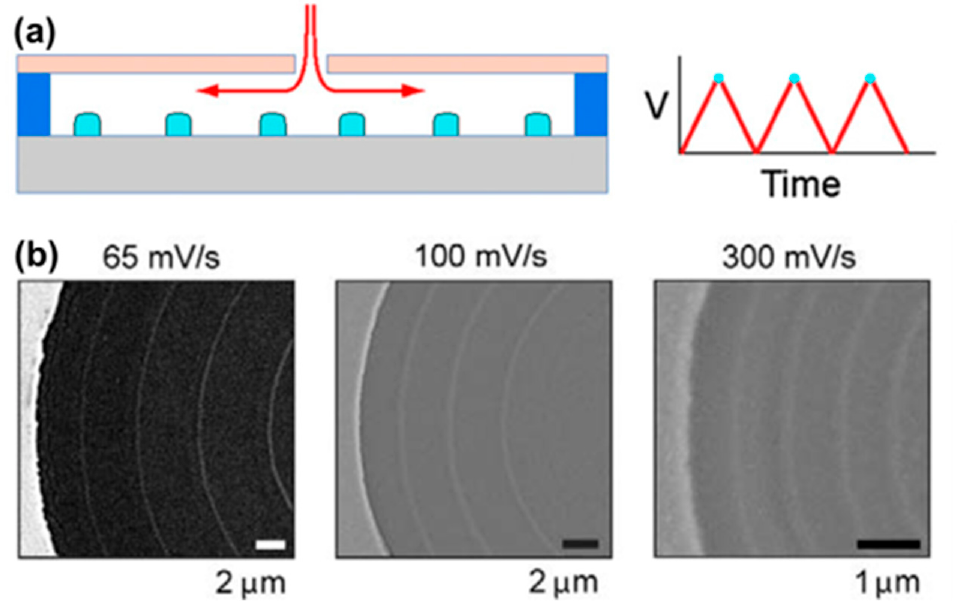
Figure 9. RIPPLE. ( a ) Schematic of RIPPLE. During linear sweeps, lateral etching of the parent material occurs in concert with site-specific localization of nanoscale periodic features (light blue). The pitch is controlled by the voltage scan rate. ( b ) SEM images of periodic Ge concentric rings patterned at different scan rates. Reprinted from ref. [90]. Copyright 2015 National Academy of Sciences.